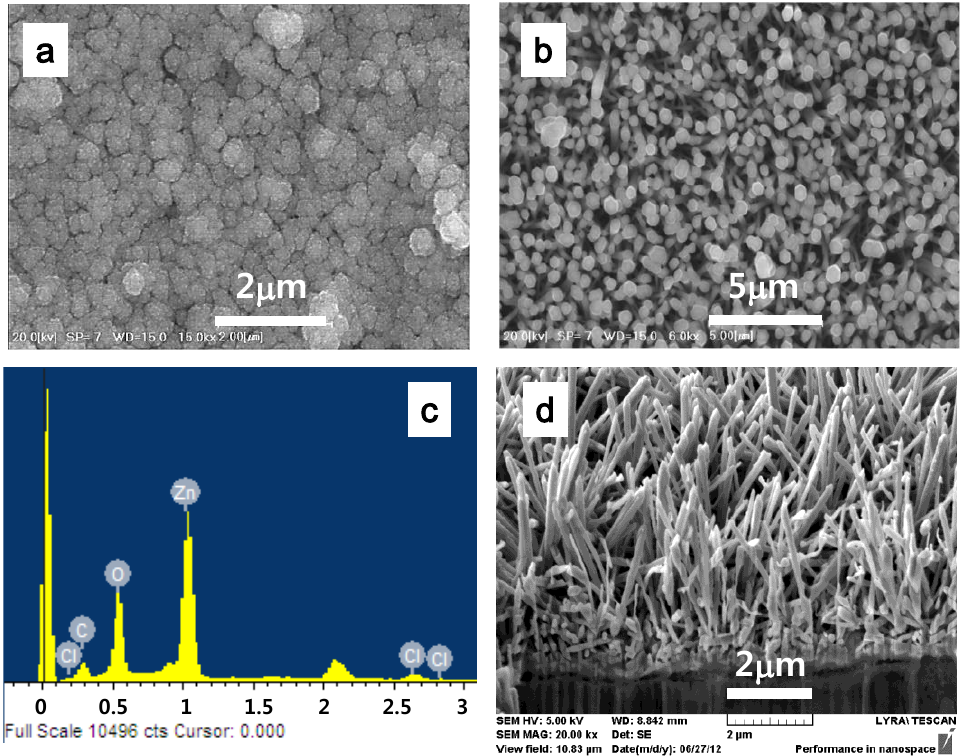
Figure 4. SEM images of CEZOHN with seeding and growing processes: ( a ) seed layer; ( b ) surface; ( c ) EDX and ( d ) cross section.